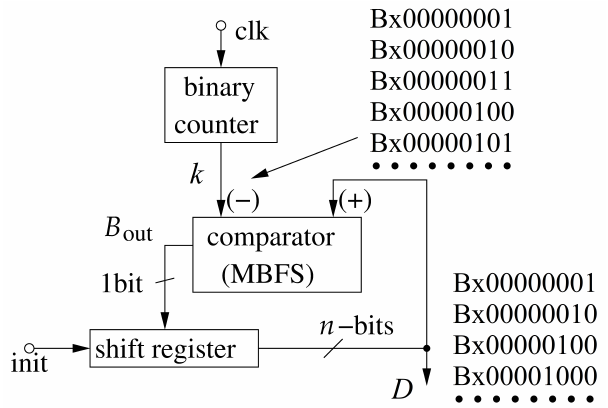
Figure 1. Proposed circuit used to switch the value of the denominator in order to control the course of the proposed deterministic